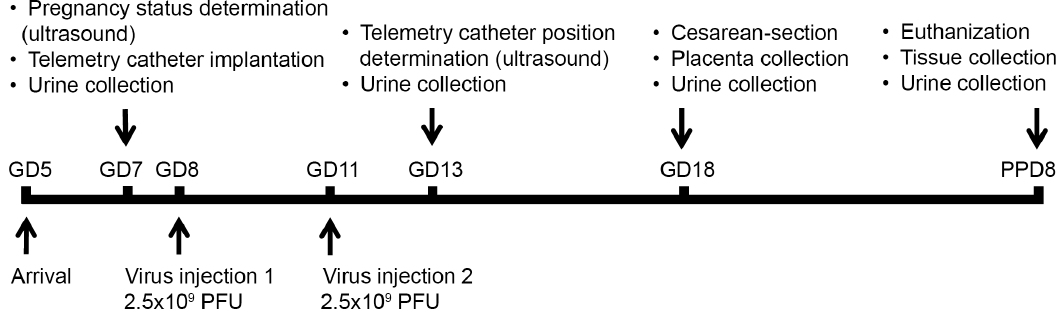
Figure 1. Experimental procedures. The flow-chart shows the experimental procedures performed at certain time-points during the study. GD, gestational day; PPD, postpartum day; PFU, plaque forming